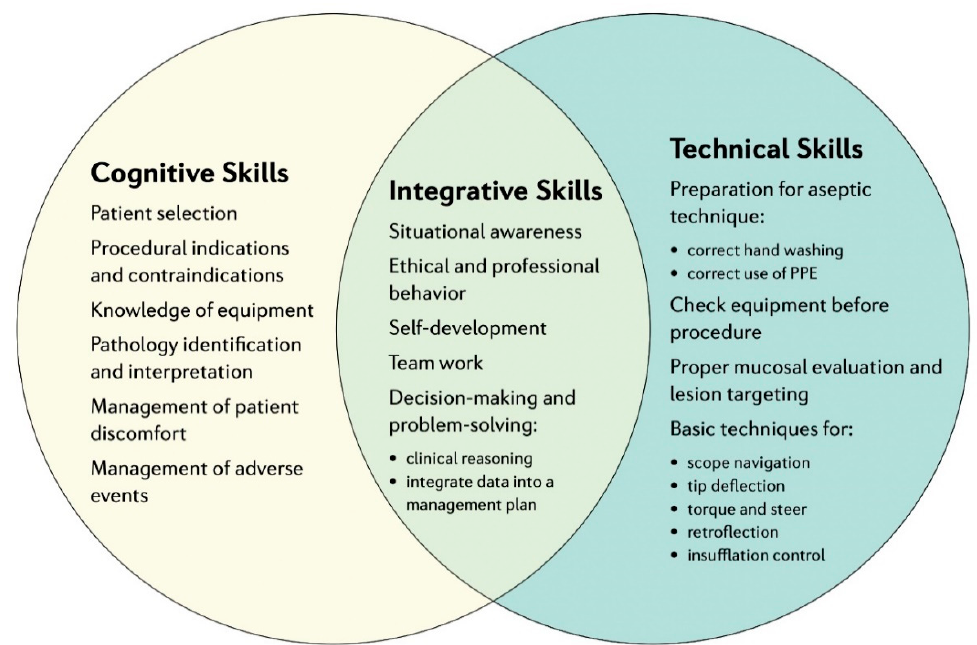
Figure 1. Skills needed for acquiring competency in gastrointestinal (GI) endoscopy—adapted from Walsh et. al. [15]. PPE: Personal Protective Equipment.